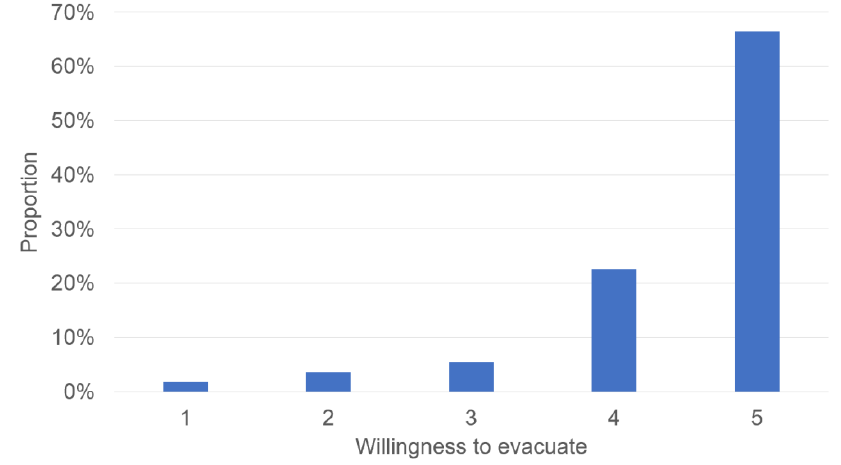
Figure 7. Statistic distribution of willingness to evacuate (Question: Would you be willing to evacuate when a disaster threatens your place? Answer: 1 = strongly disagree, 2 = disagree, 3 = neutral, 4 = agree, 5 = strongly agree).